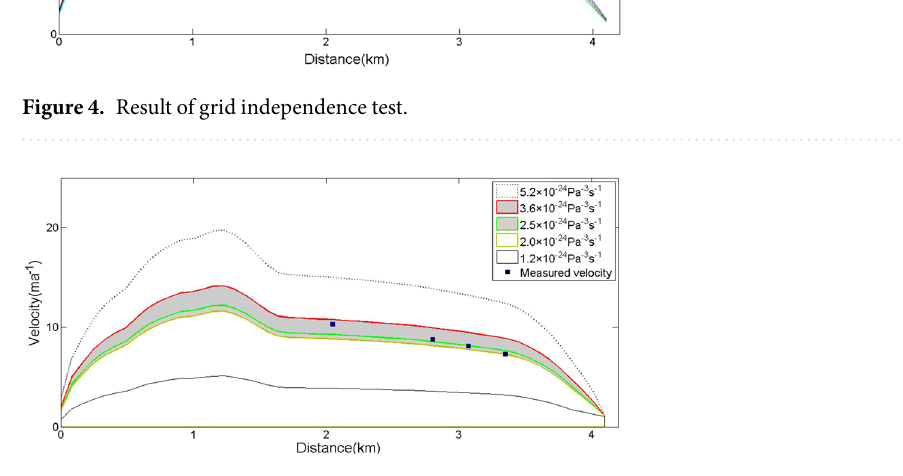
Figure 5. Measured and simulated glacial surface velocity along the main streamline. The simulated surface velocity represented different values of the flow - law coefficient A without basal